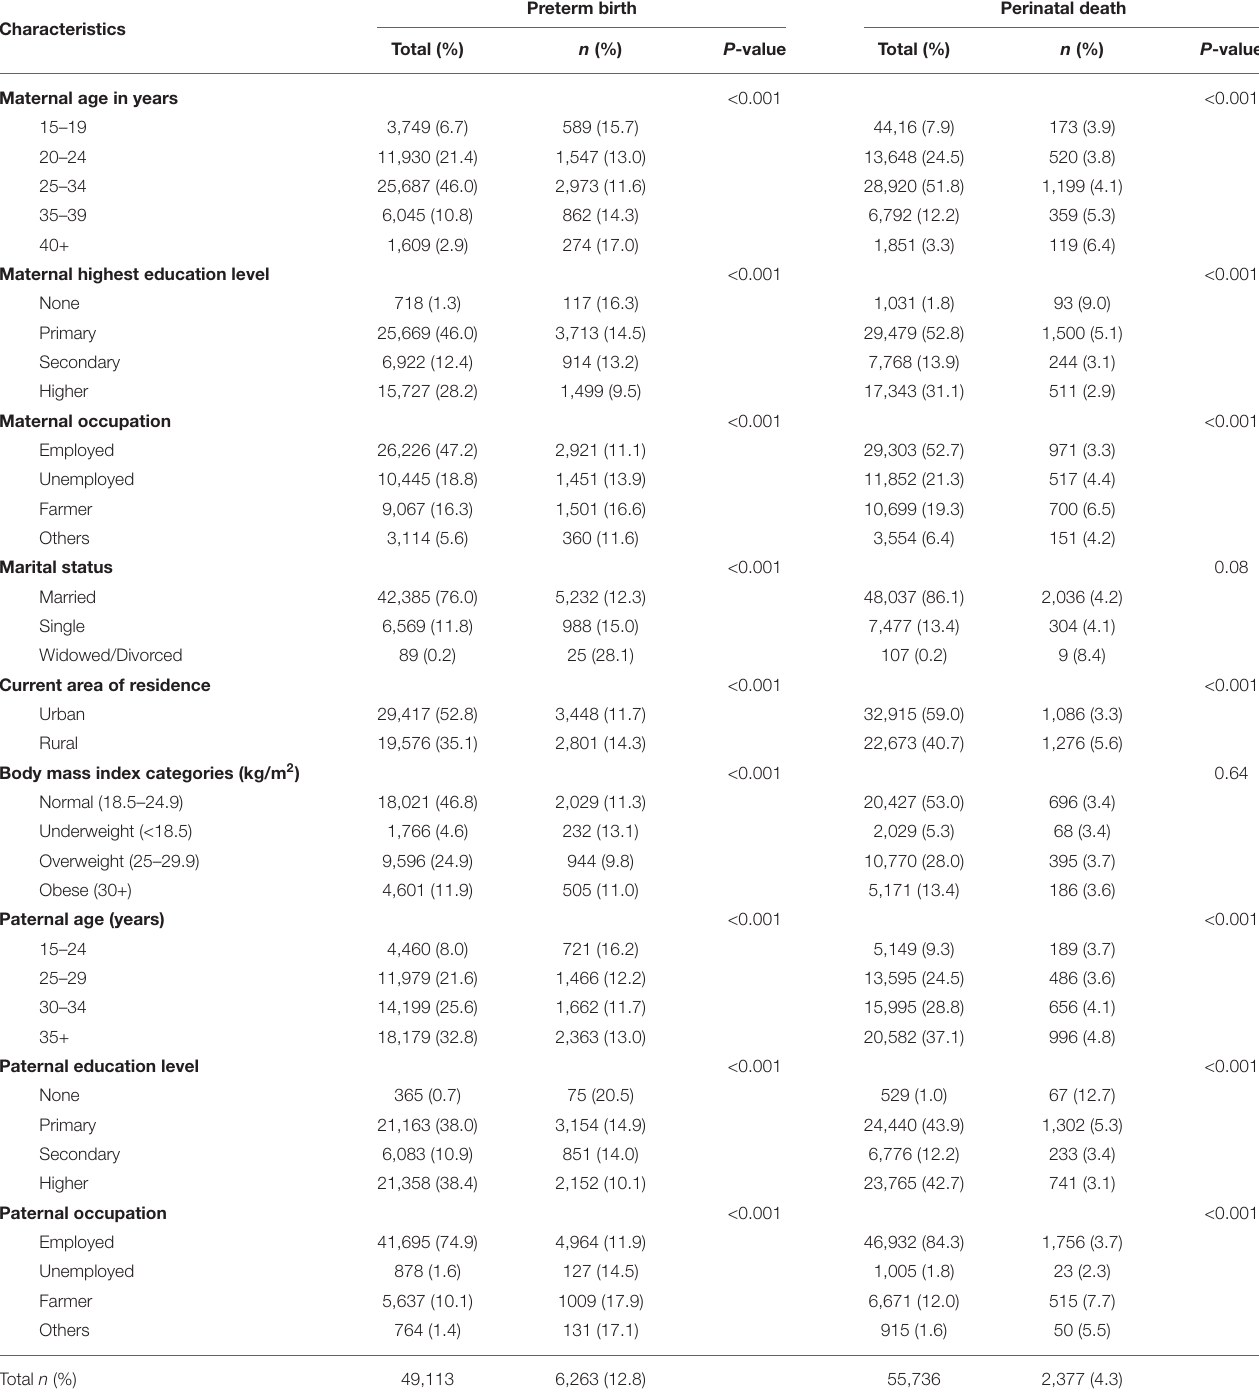
TABLE 1 | Distribution of preterm birth and perinatal death by maternal and paternal characteristics ( N = 55,907).